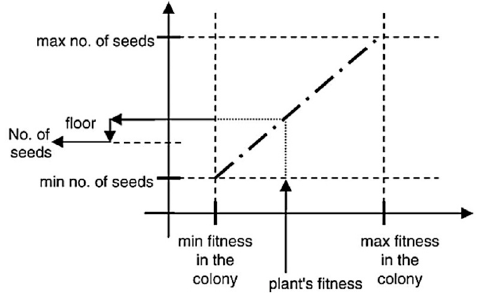
Figure 5. The seed reproduction of the invasive weed optimization (IWO) algorithm.